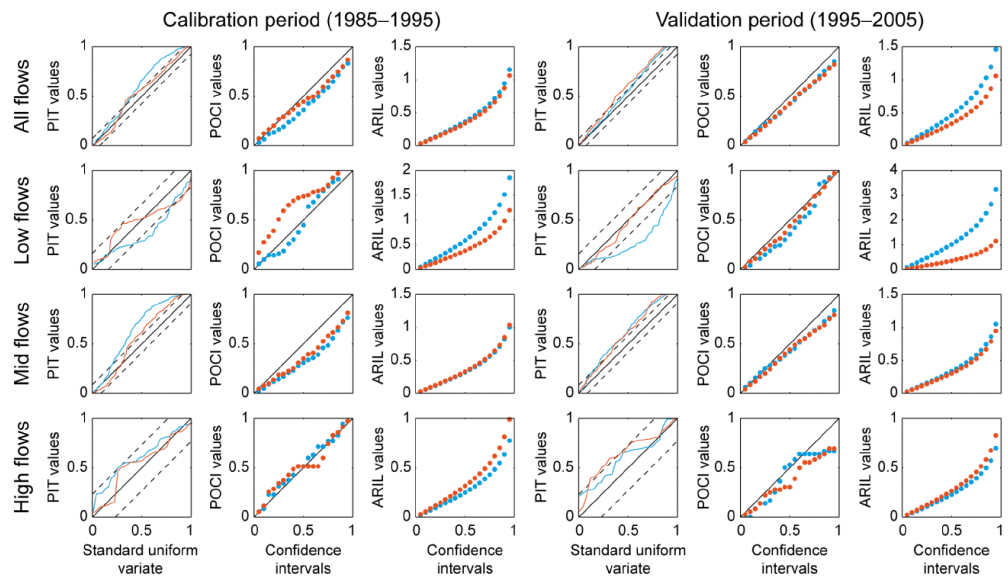
Figure 9. Posterior diagnostics used to evaluate the reliability (PIT, POCI) and resolution (ARIL) of the forecast distributions obtained with Model B (in blue) and Model C (in